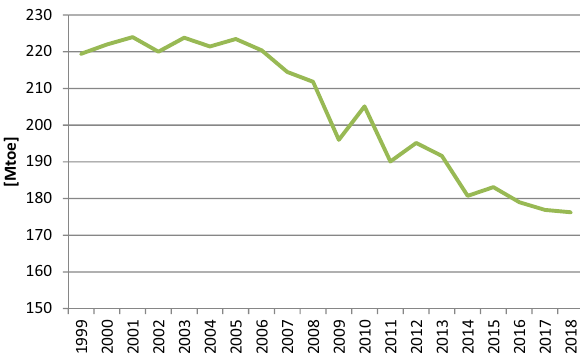
Figure 6: Primary energy consumption in the United Kingdom between 1999 and 2018. Source: own work based on ref. [ 5 ] .